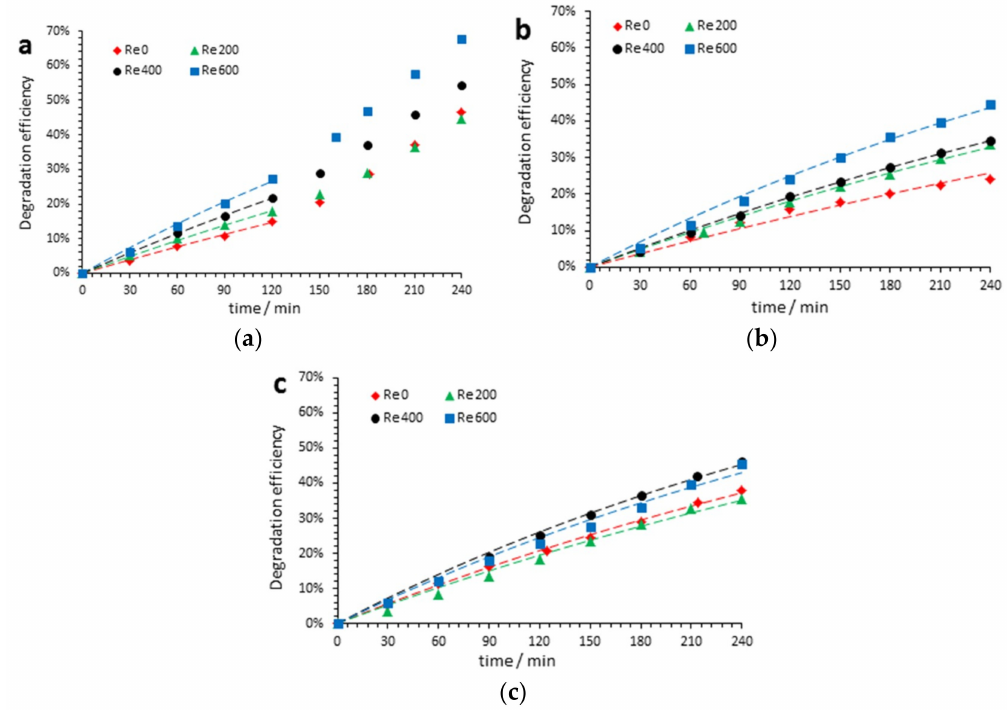
Figure 3. Photoelectrocatalytic (PEC) degradation efficiencies of acetaminophen by means of absorbance measurements with an ultraviolet-visible spectrophotometer with TiO 2 nanostructures anodized (at Re 0, 200, 400, and 600 with lengths of 3.7, 5.0, 5.4, and 6.1 µ m, respectively) during the 240 min of the degradation test for ( a ) pH 3, ( b ) pH 7, and ( c ) pH